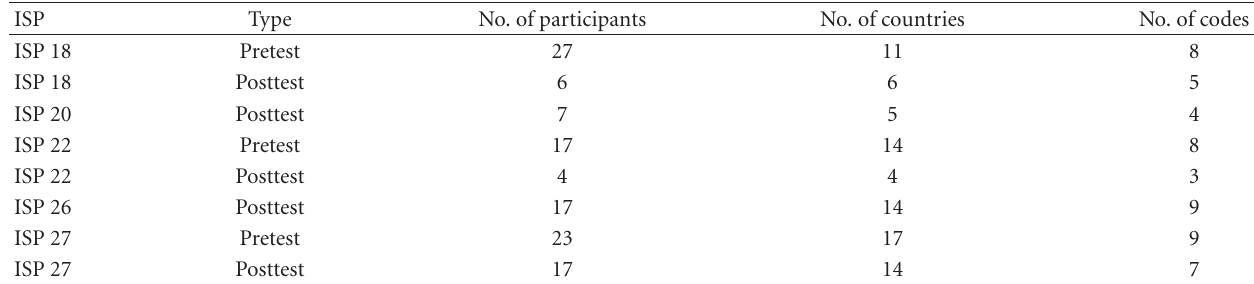
Table 7: Countries, Participants, and Codes used per ISP.